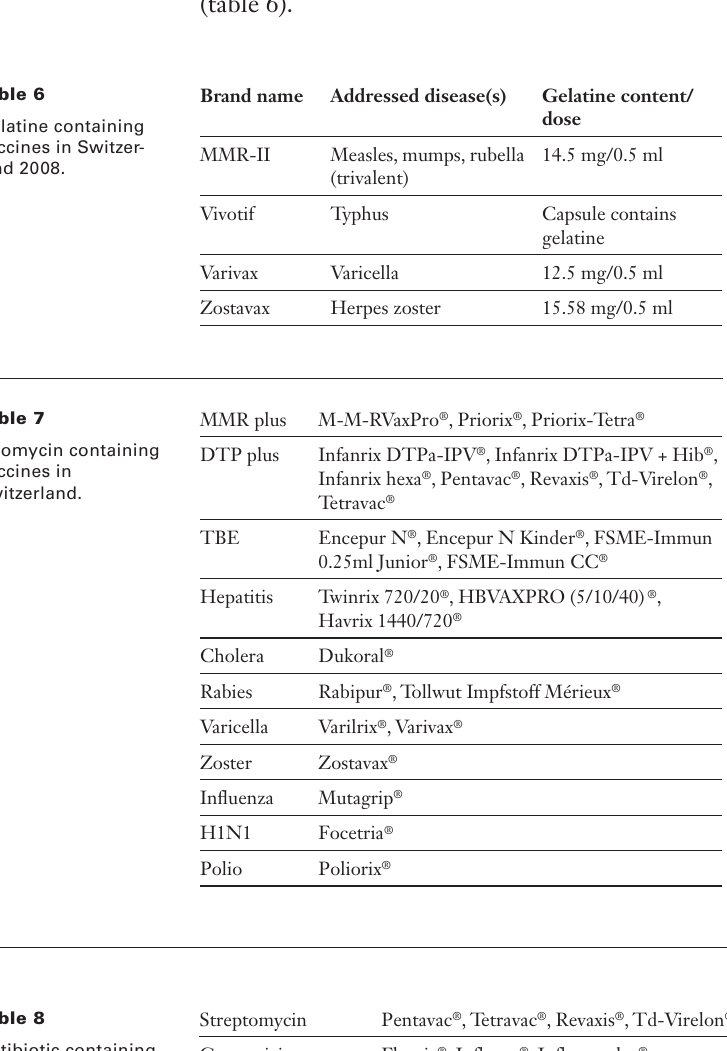
Antibiotic containing vaccines